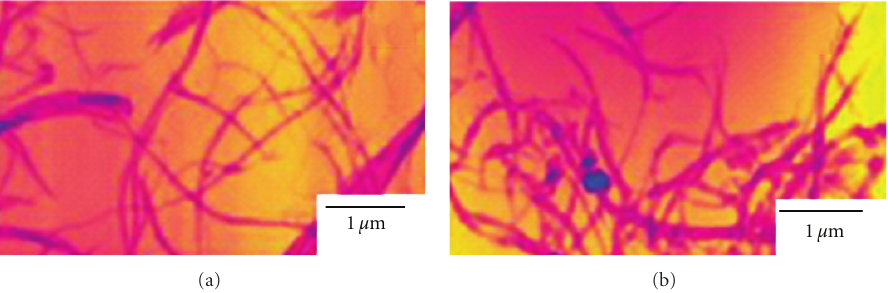
Figure 4: AFM images (a) hard- and (b) softwood cellulose nanofibers at process equilibrium